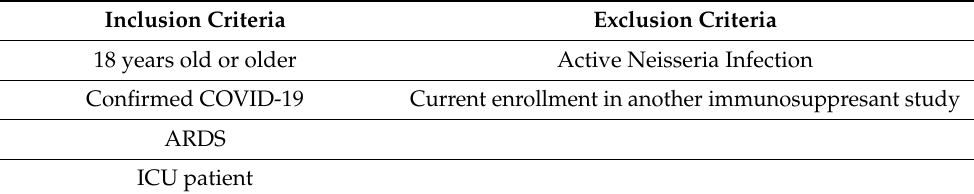
Table 1. Inclusion and Exclusion Criteria.